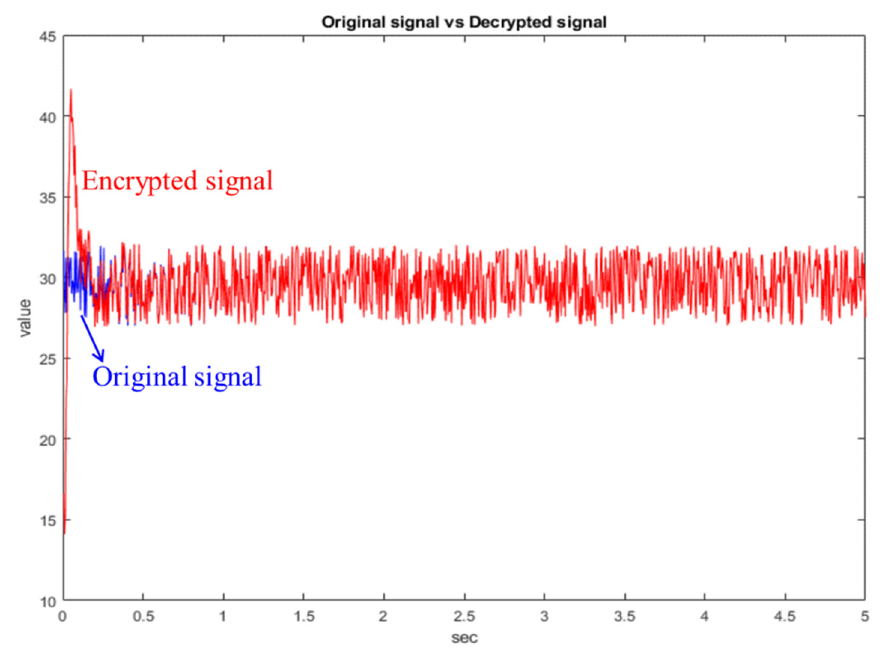
Figure 11. Comparison chart of original signal and decrypted signal.